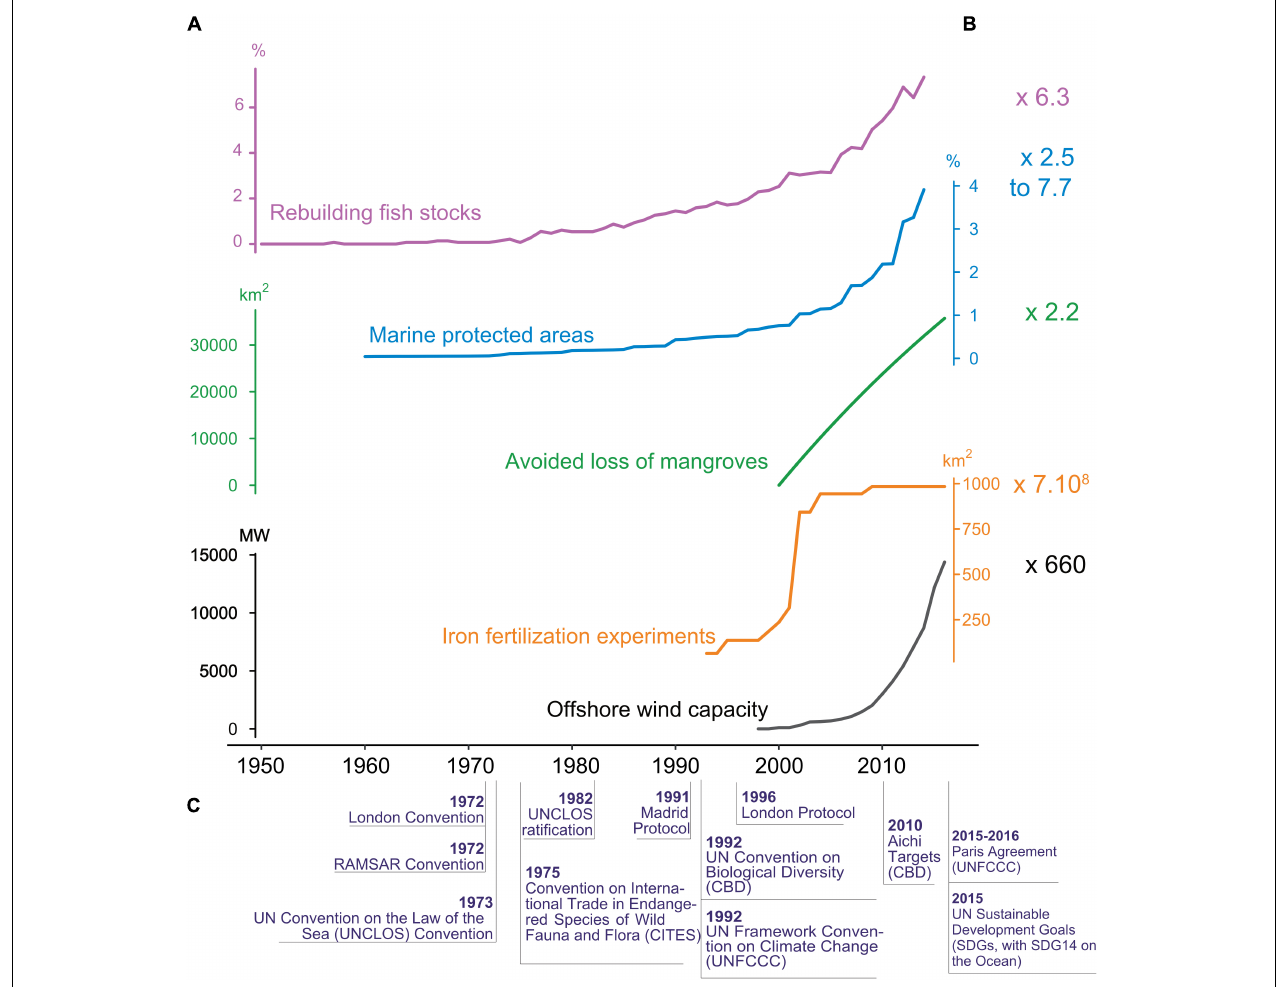
FIGURE 3 | Contemporary history of the global implementation of some ocean solutions. (A) Recent changes in the global cumulative offshore wind potential (European Wind Energy Association, 2011; Global Wind Energy Council, 2016), global cumulative surface of ocean iron fertilization experiment patches (Yoon et al., 2016), global area of avoided loss of mangroves (Valiela et al., 2001; Hamilton and Casey, 2016), rebuilding of fish stocks (Kleisner et al., 2013) (in % of total fish stocks), and global cumulative surface of MPAs (Boonzaier and Pauly, 2016) (in % of the global ocean surface). (B) Future progress needed to reach full implementation of targets for all measures above, i.e., 300 EJ year − 1 for offshore wind, all ocean high nutrient and low chlorophyll areas for iron fertilization, 10 and 30% of the global ocean for MPAs (Convention for Biological Diversity, 2010; O’Leary et al., 2017), all overexploited and collapsed fish stocks in the process